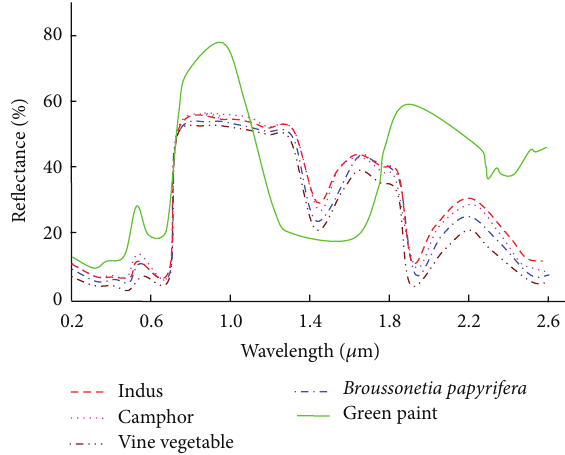
Figure 3: The differences between green paint spectrum and vegetation